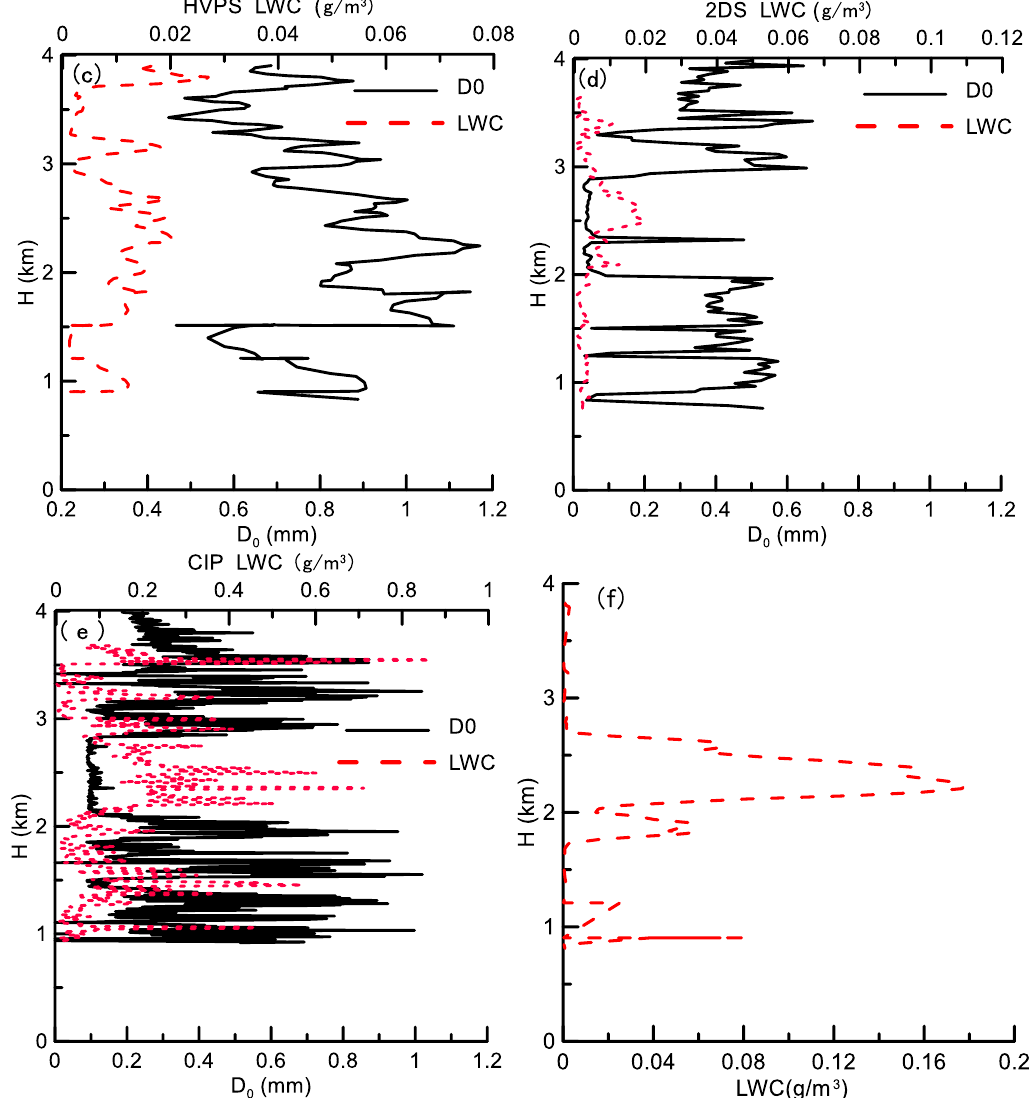
Figure 9. Vertical profiles of Z and vertical air motion retrieved by cloud radar (CR) ( a ), D 0 and liquid water content (LWC) by CR ( b ), HVPS ( c ) , 2DS ( d ) , CIP ( e ) and LWC by hotwire ( f ).